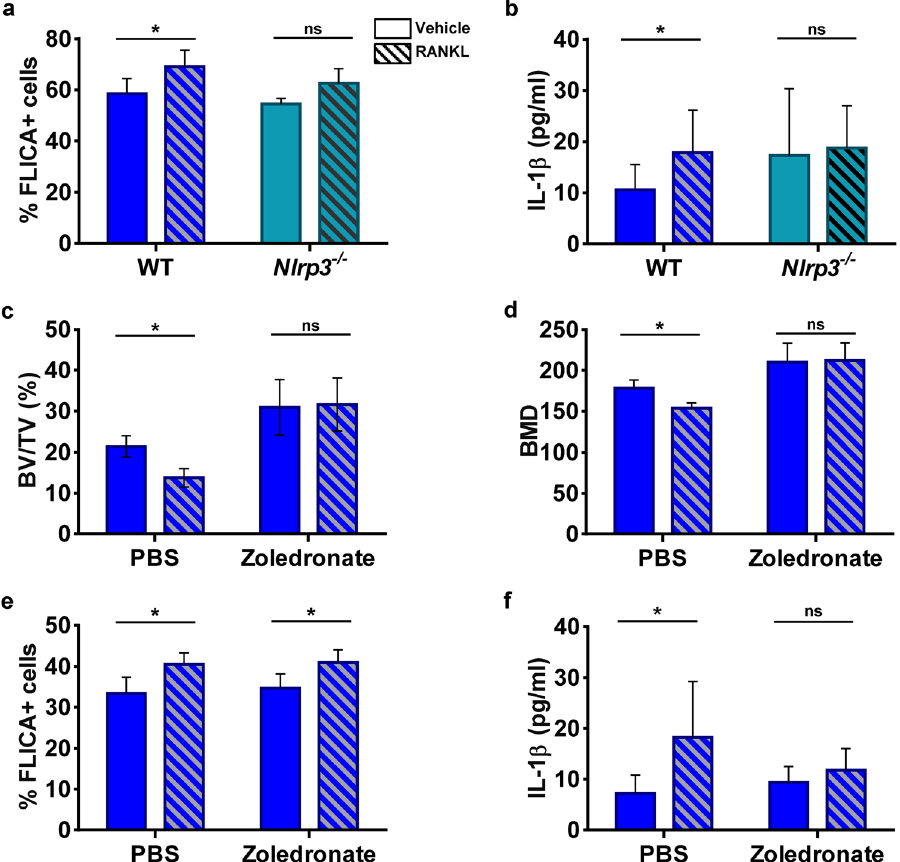
Figure 6. The inflammasomes are activated in the bone environment in response to cues released during bone resorption. RANKL was administrated (1 µ g/kg, daily, for 2 days) to WT or Nlrp3 − / − 3-month old male mice. ( a ) Percentage of FLICA + cells in whole bone marrow cells determined by flow cytometry (n = 5–7 mice/ group); * p = 0.0225. ( b ) IL-1 β production in bone marrow (n = 6–16 mice/group); * p = 0.0126 (multiple t-test and Holm-Sidak). ( c and d ) WT 3-month old mice were given 40 µ g/kg zoledronate or PBS once a week for 4 weeks before RANKL treatment (n = 5 mice/group). Bones were analyzed by µ CT. BV/TV: * p = 0.0274; BMD: * p = 0.0351. ( e ) FLICA + bone marrow cells (n = 5 mice/group). * p = 0.0275 for the PBS group; * p = 0.0408 for the zoledronate group. ( f ) IL-1 β release in bone marrow (n = 5 mice/group). * p =